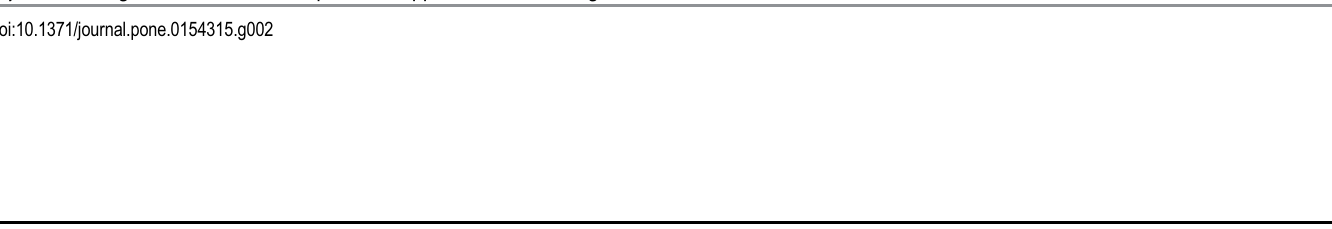
PLOS ONE | DOI:10.1371/journal.pone.0154315 April 27,